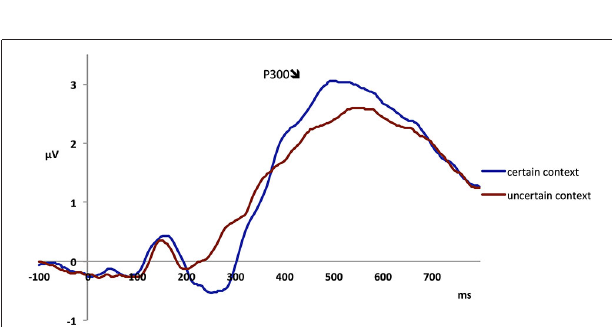
FIGURE 6 | Electrophysiological data shows that offers presented in the certain context elicit higher P300 amplitudes than those presented in the uncertain context.